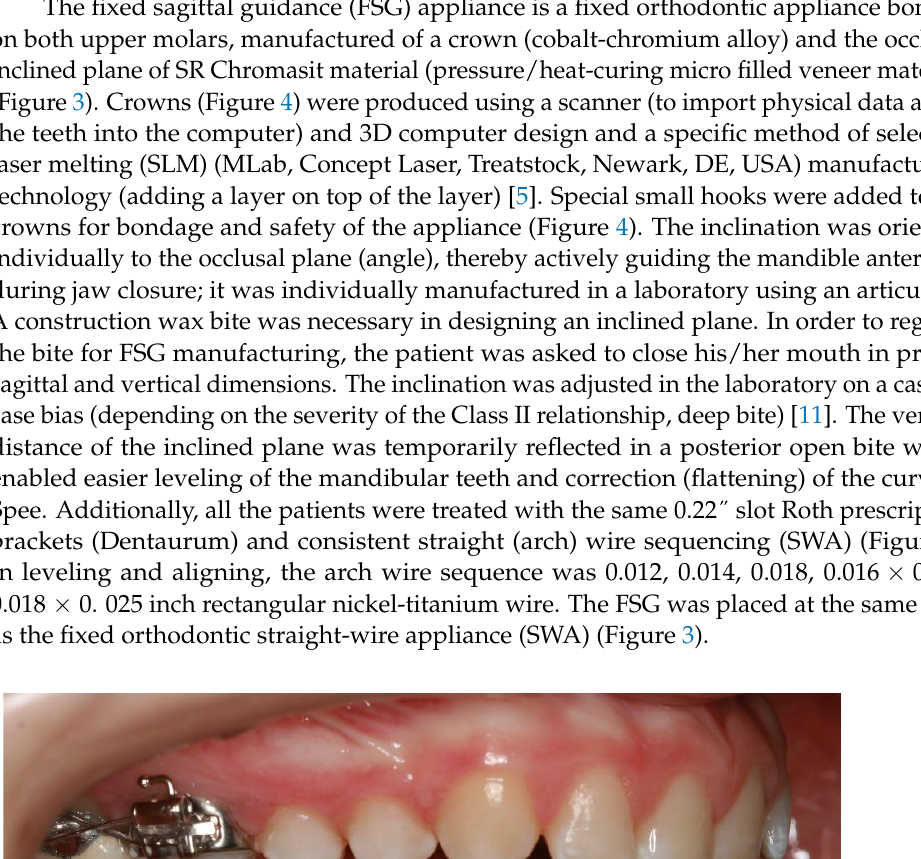
Figure 4. Crowns (with safety hooks) were produced using 3D computer design and additive man- ufacturing technology (selective laser melting (SLM)). Final skeletal and dentoalveolar results of the patients treated with FSG were com- pared with the same results of patients treated with intermaxillary Class II elastics (control group), who matched to the FSG group in age and initial cephalometric characteristics. Statistical Analysis Intra-operator error was evaluated by re-digitizing fifteen randomly selected cepha- lograms two weeks after initial digitization. Error analysis was performed using paired t - tests. Descriptive statistics (mean and standard deviation) for measurements before and after treatment were analyzed using the Statistical Package for Social Sciences version 10.0 (SPSS Inc., Chicago, IL, USA). An independent t -test was used to compare cephalometric measurements before and after treatment within each group and paired t -test for comparison between groups. The level of significance tested was p < 0.05.